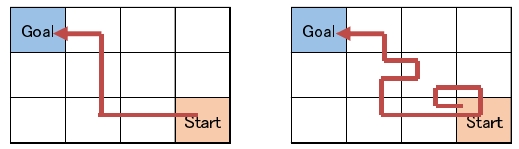
Figure 2: Actions putted value (left) and all actions